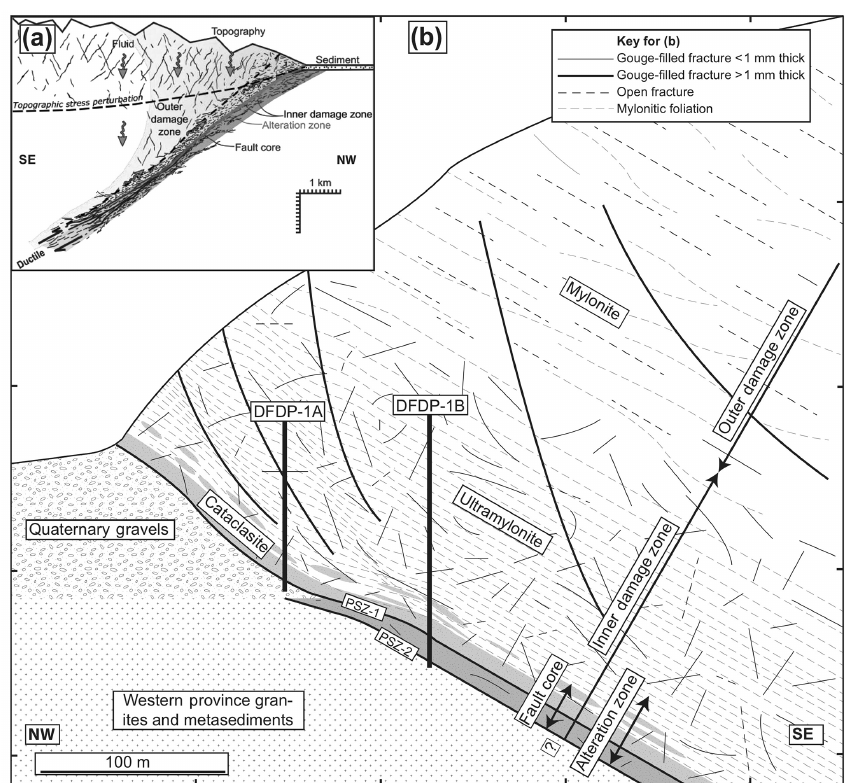
Figure 12. Schematic cross sections through the Alpine Fault illustrating its hanging-wall structure. (a) Crustal-scale cross section illustrating the flower-shaped geometry of the outer damage zone (after Townend et al., 2017). (b) A thrust section within the central section of the Alpine Fault, depicting fracture network, its relationship to foliation, and the distribution of subsidiary faults. Respective position of DFDP-1 boreholes is also shown. Constructed from cross sections previously presented in Norris and Cooper (2007) and Sutherland et al.